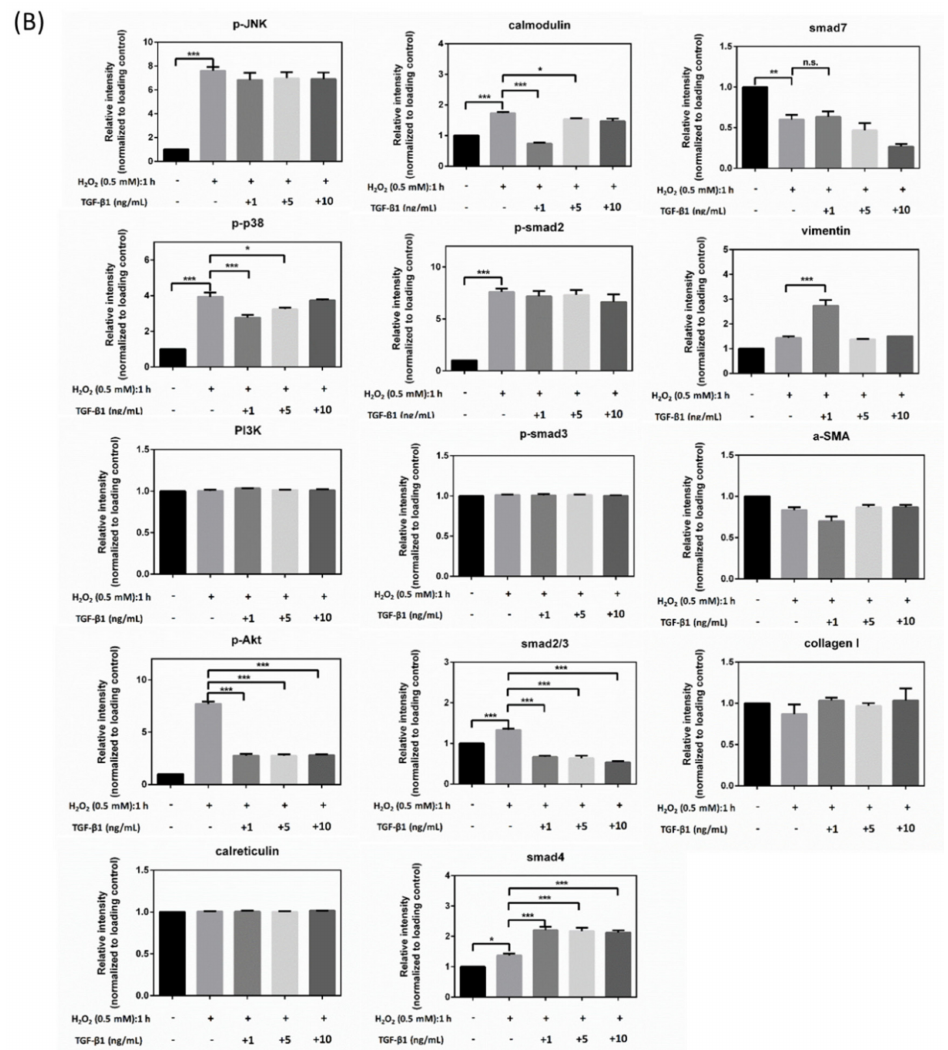
Figure 5. Immunoblot analysis and identification of rhTGF- β 1 protein in oxidative stress pathways. ( A ) Cells were collected after treatment with specific rhTGF- β 1 concentrations (1, 5, 10 ng/mL) followed by H 2 O 2 (0.5 mM) treatment for 1 h, and cellular extracts were immunoblotted with p-JNK, JNK, p-p38, p38, PI3K, p-AKT, AKT, calreticulin, calmodulin, p-SMAD2, p-SMAD3, SMAD2/3, SMAD4, SMAD7, vimentin, alpha-smooth muscle actin ( α -SMA), and collagen I as shown with the protein bands. Oxidative stress-dependent increases in ECM proteins (vimentin), stress response, and Ca 2+ -modulated proteins were observed over time. Numbers under each protein band reflect the densitometry value. ( B ) The protein expression intensities were quantified in relation to the loading control. Statistic chart were represented as means ± SEM. *, p < 0.05; **, p < 0.01; ***, p < 0.001; n.s., non-significant; ( n =